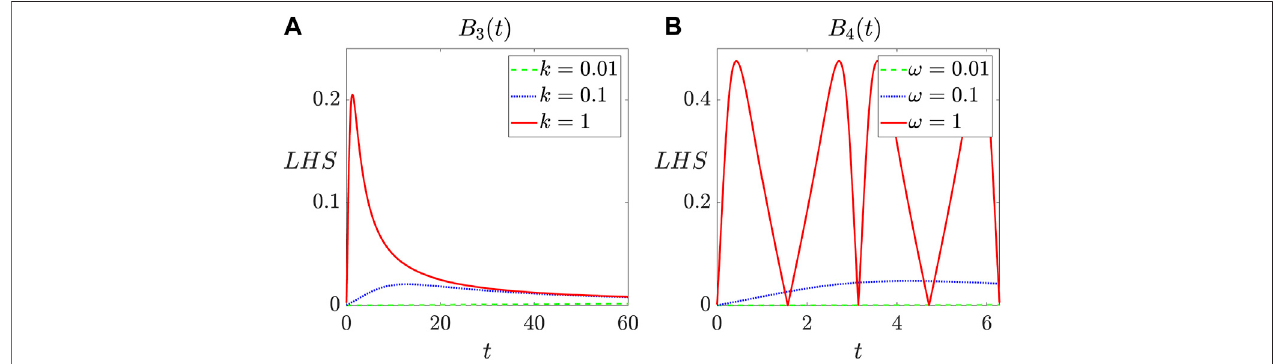
FIGURE 2 | LHS of the adiabatic approximation condition versus time t for different magnetic fi elds: (A) B 3 ( t ) and (B) B 4 ( t